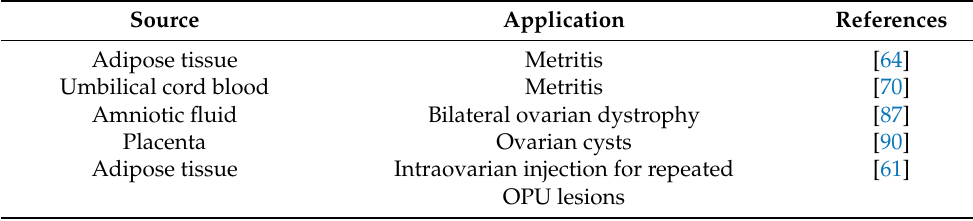
Table 3. Bovine MSCs from different sources for treatment of reproductive system